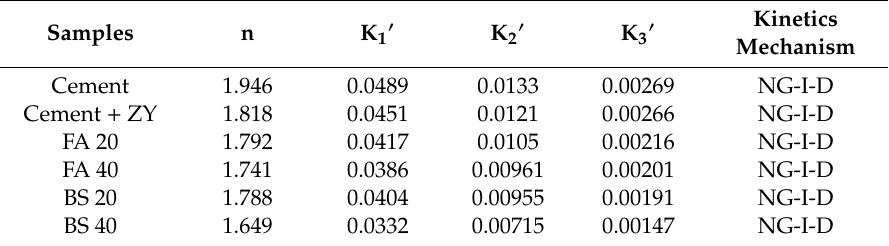
Table 3. Main parameters of early hydration kinetics of blended